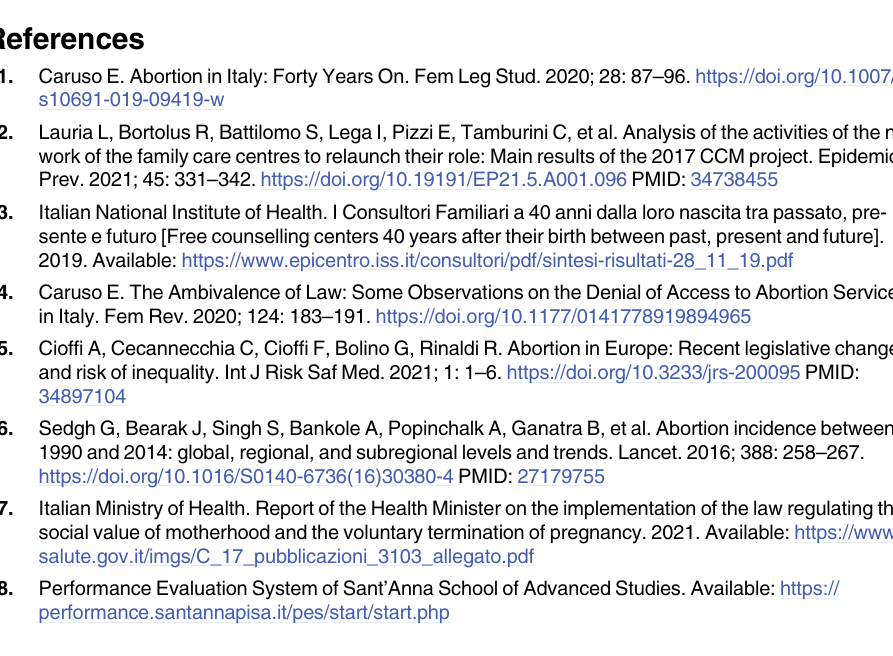
S1 Table. Details on data sources and variable selection. S2 Table. READ-IT scores for LHA and TH websites (and details on the READ-IT tool). S3 Table. Total and certified abortion rates for each health